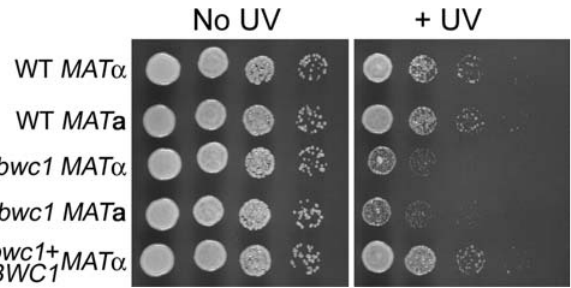
Figure 3. bwc1 Mutants Are Hypersensitive to UV Light Ten-fold serial dilutions of log-phase yeast cells of bwc1 mutant or wild type (WT) were plated in duplicate on YPD medium, and one plate was UV irradiated ( ; 48 mJ/cm 2 ). Reintroduction of a wild-type copy of the BWC1 gene into the bwc1 þ BWC1 mutant strain restores UV sensitivity to the wild-type level. DOI: